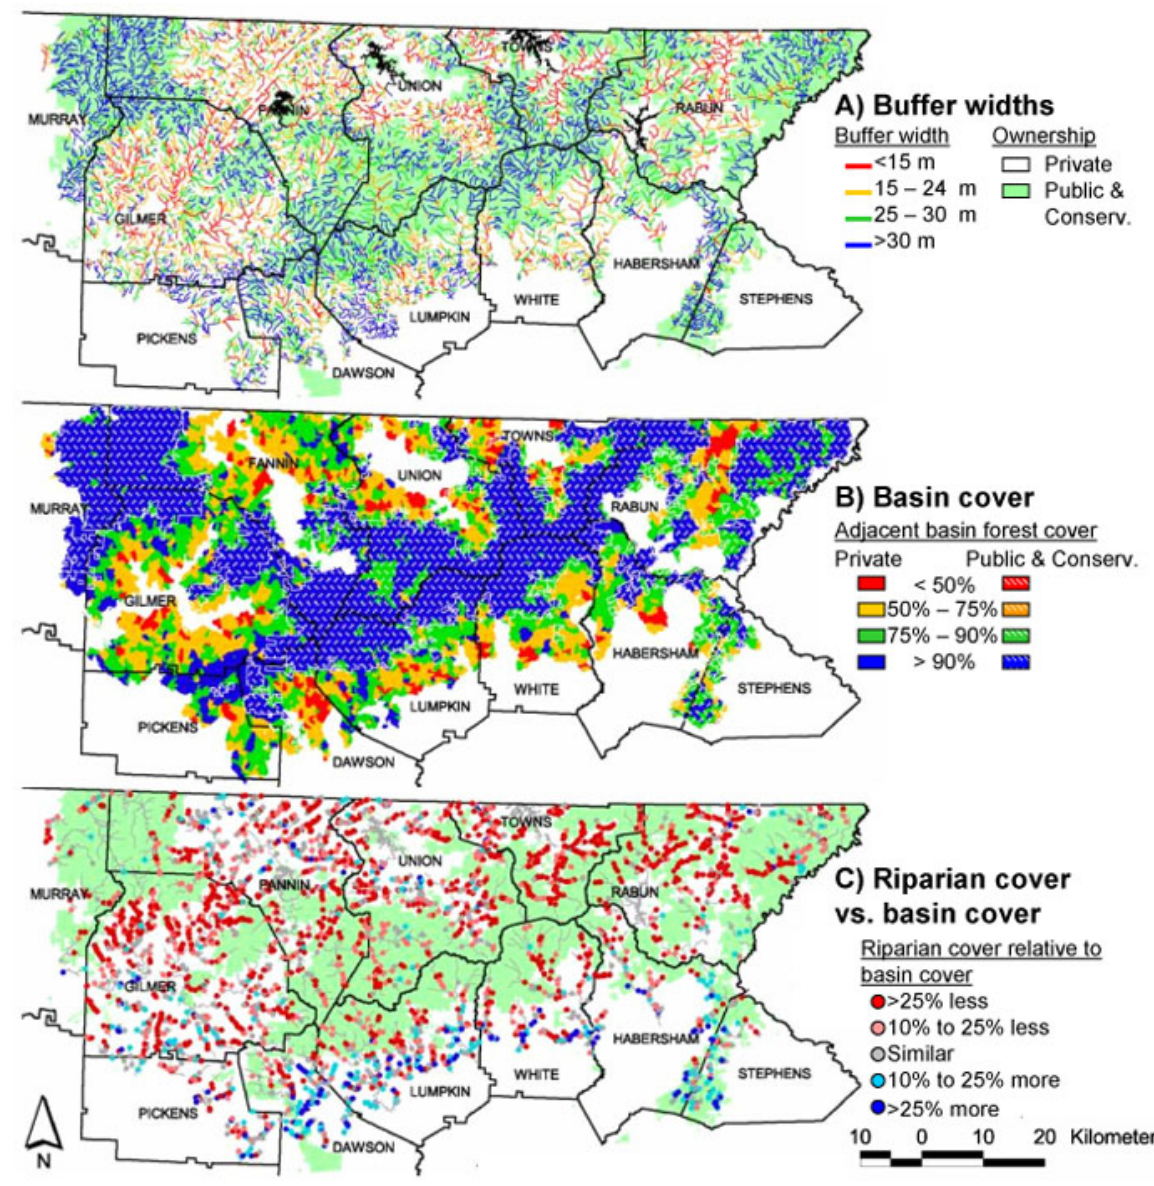
Fig. 3. Existing riparian and basin forest conditions across the trout stream network and by land ownership. A) Average forested riparian buffer widths were estimated for more than 8000 stream segments using Eq. 1 from this study. B) Percent forest cover in the adjacent basins (defined in Fig. 2C) for 2 nd - to 5 th -order stream segments with basin areas between 5–50 km 2 . C) Forest cover in riparian buffers relative to adjacent basin areas for 2 nd - to 5 th -order stream segments with basin areas between 5– 50 km 2 . Streams without dots have riparian and basin cover values <90%. Red riparian zones are less forested than adjacent basin areas. For more information on the analysis of existing forest and thermal conditions across Georgia’s trout stream network in relation to land ownership, see App.